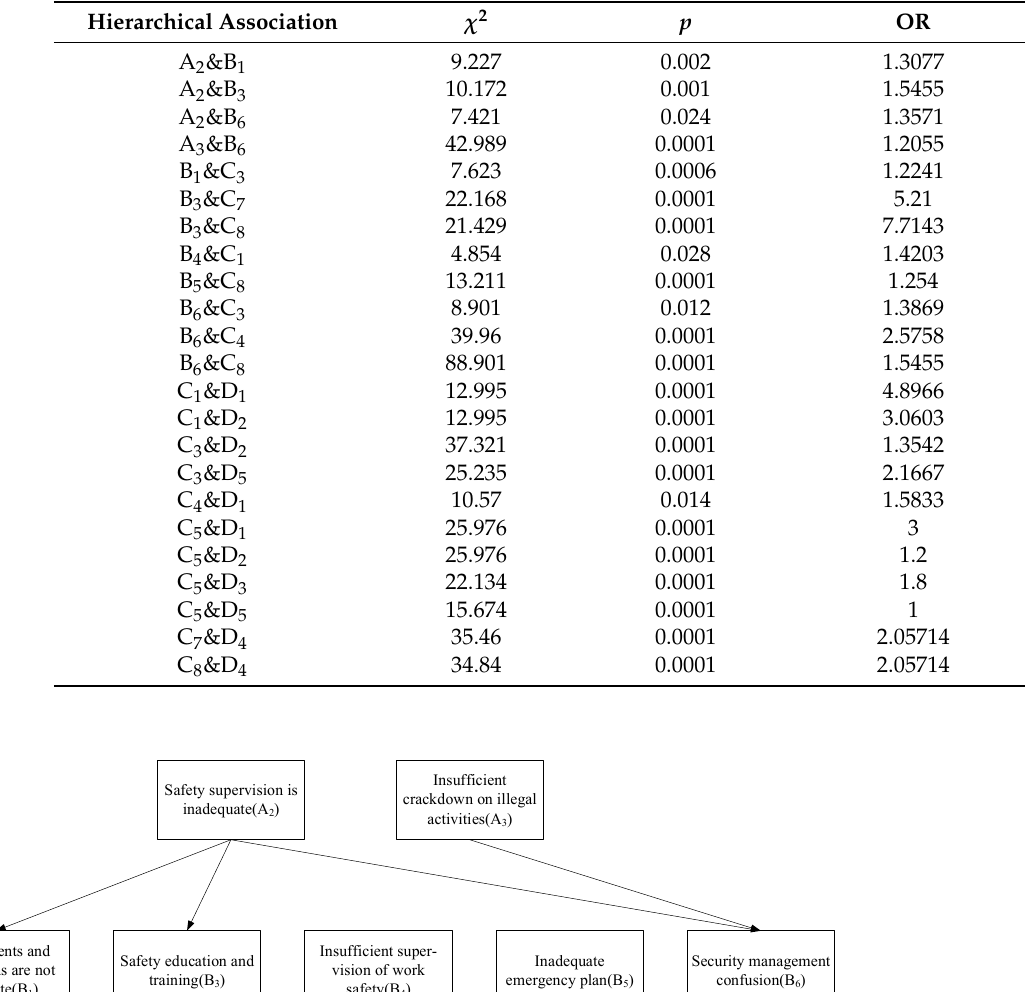
Table 5. Chi-square test and OR values statistics table.